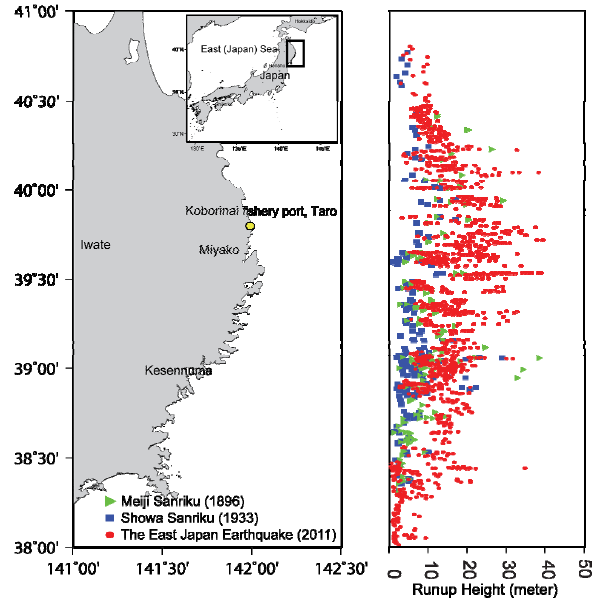
Figure 1. Observed runup height distributions from the 1896, 1933 and 2011 tsunamis 5 Fig. 1. Observed runup height distributions from the 1896, 1933, and 2011 However, measured maximum tsunami heights should be interpreted carefully because they 7 are sometimes the heights of splash-up and are not representative of runup heights in a 8 specific region. Even in a limited coastal region, the runup heights varied widely due to 9